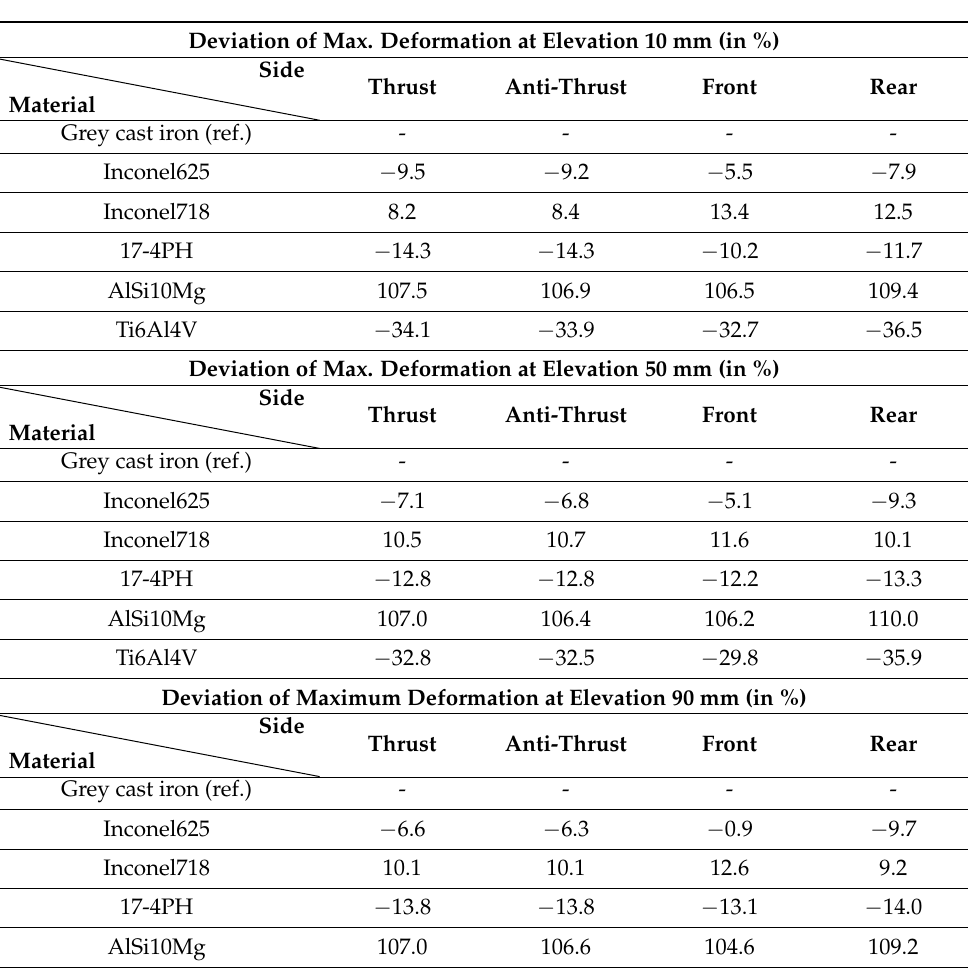
Table 2. Deviation of max. deformation at elevations of 10, 50 and 90 mm from the top compared with the reference material. Deviation of Max. Deformation at Elevation 10 mm (in %) Side Thrust Anti-Thrust Front Rear Material Grey cast iron (ref.) - -